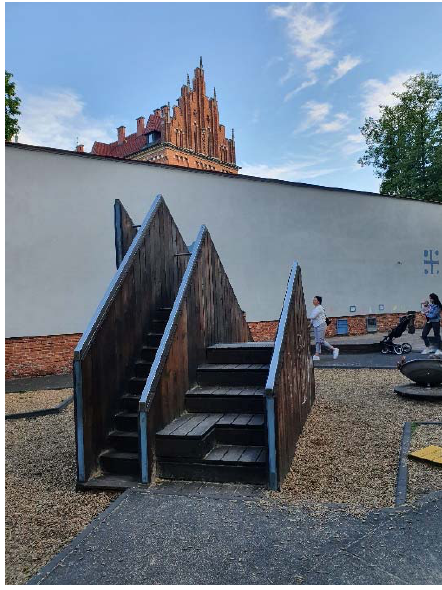
Figure 9. Planty’s playground detail, Kraków, designer: Pracownia K. (Photos by the authors, 2021).